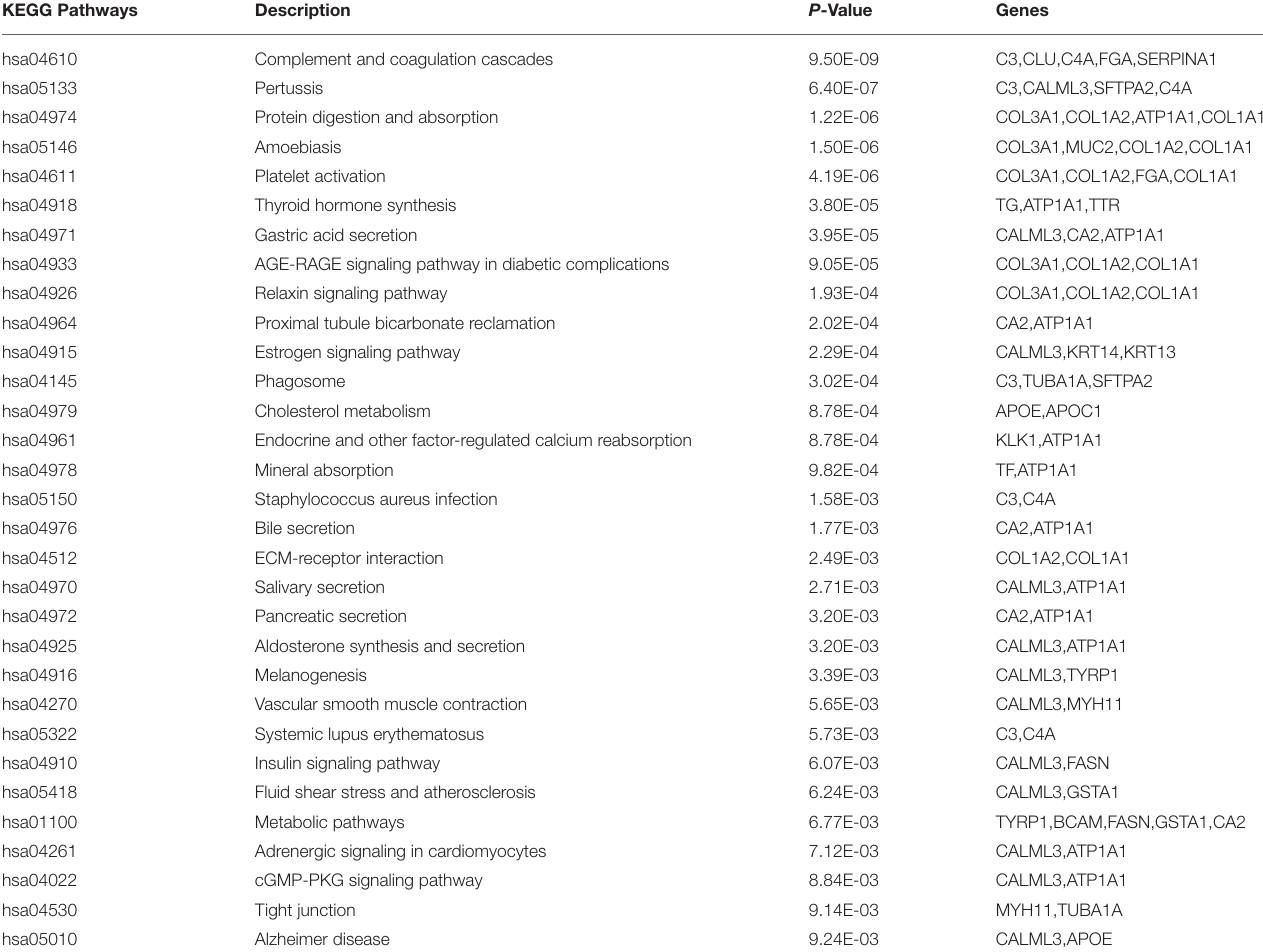
TABLE 8 | The KEGG pathway analysis. KEGG